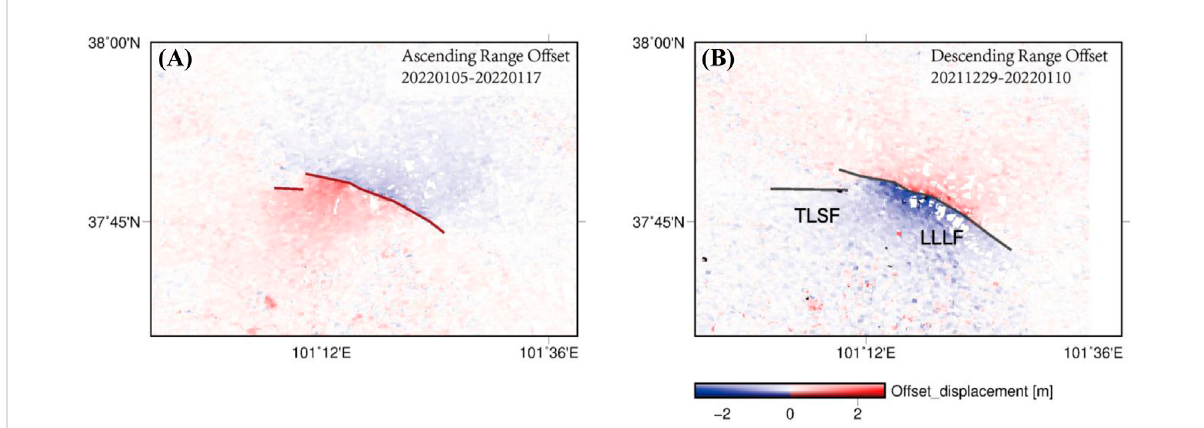
FIGURE 5 Range offsets derived from Sentinel-1A ascending track 128 (A) and descending track 033 (B) by using the offset-tracking technique. The dark- redlinemarkedin (A) indicatesthe fi eld-investigatedsurfacerupturefromPanetal.(2022),andthegraylinemarkedin (B) indicatesthetwo-segment fault model used in our Slip inversion in Section